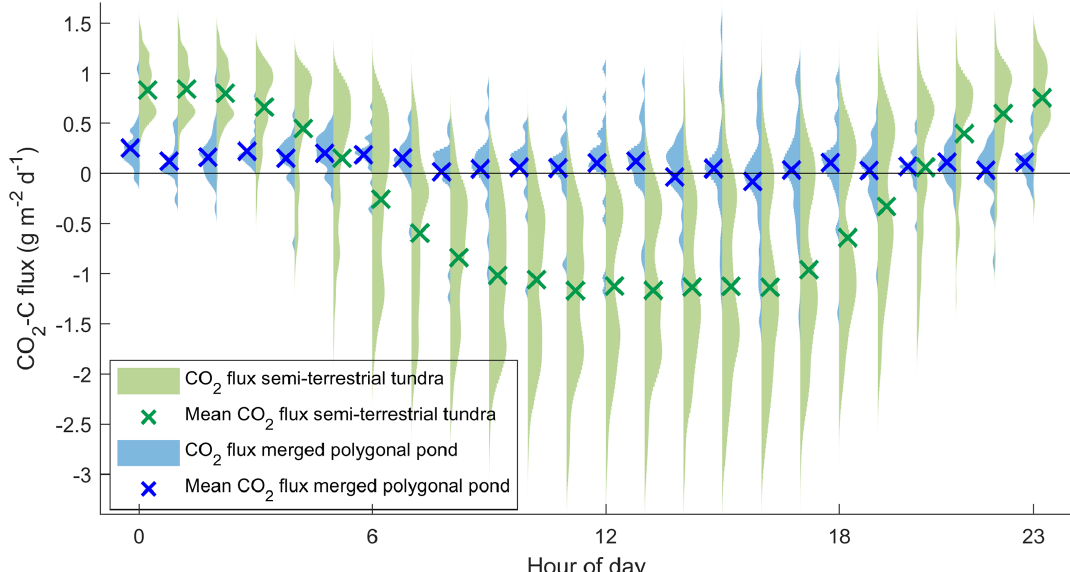
Figure 4. Diurnal cycle of modeled CO 2 –C based on observations flux from the merged polygonal pond (blue, Eq. 4) and the semi-terrestrial tundra (green, Eq. 5) as violin plots for each half-hour flux. Blue and green crosses mark the mean CO 2 –C flux during each half-hour flux. A violin plot shows the distribution of measurements along the y axis – the width of the curves indicates how frequently a certain y value